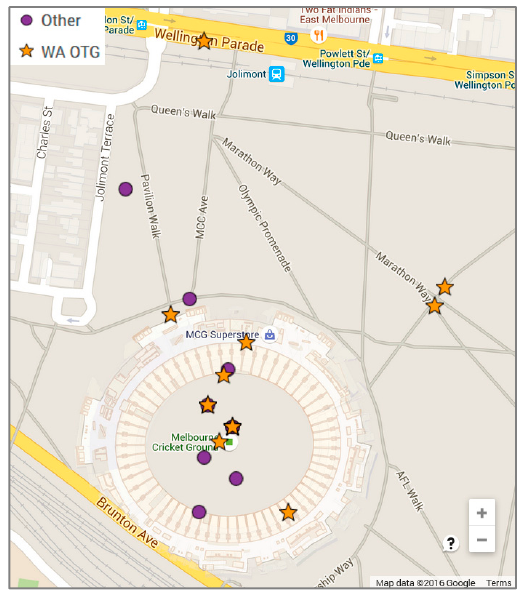
Figure 6. Map depicting the location of images with geotags categorized as WA OTG vs. other categories for the ADon and GFon dataset.